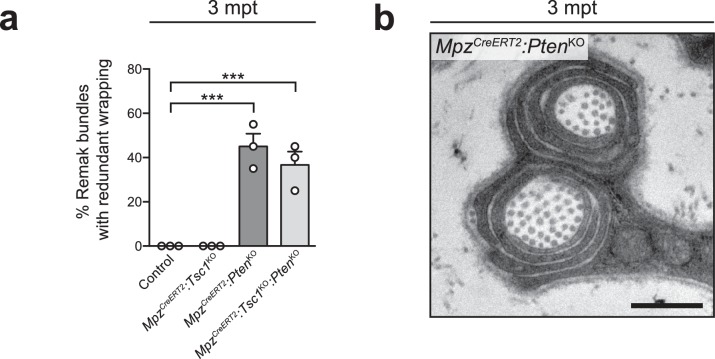
Redundant membrane wrapping in inducible knockout mice for PTEN, alone or in combination with TSC1.(a) Quantification referring to Figure 5k. For each nerve, 20 Remak bundles were randomly selected, imaged, and the percentage of bundles containing at least one fiber with at least 1.5 wraps of Remak cell membrane was calculated. Bar height: mean; error bars: s.e.m. (n = 3 mice/genotype, one-way ANOVA with Dunnett’s multiple comparisons test, F(3,8) = 32.68, p<0.0001; pcontrol vs PTENKO = 0.0002, pcontrol vs doubleKO = 0.0007). (b) Electron micrograph showing a Remak cell membrane wrapping around collagen fibers in inducible PTEN mutants (n = 3 mice). Scale bar: 500 nm. ***p<0.001.